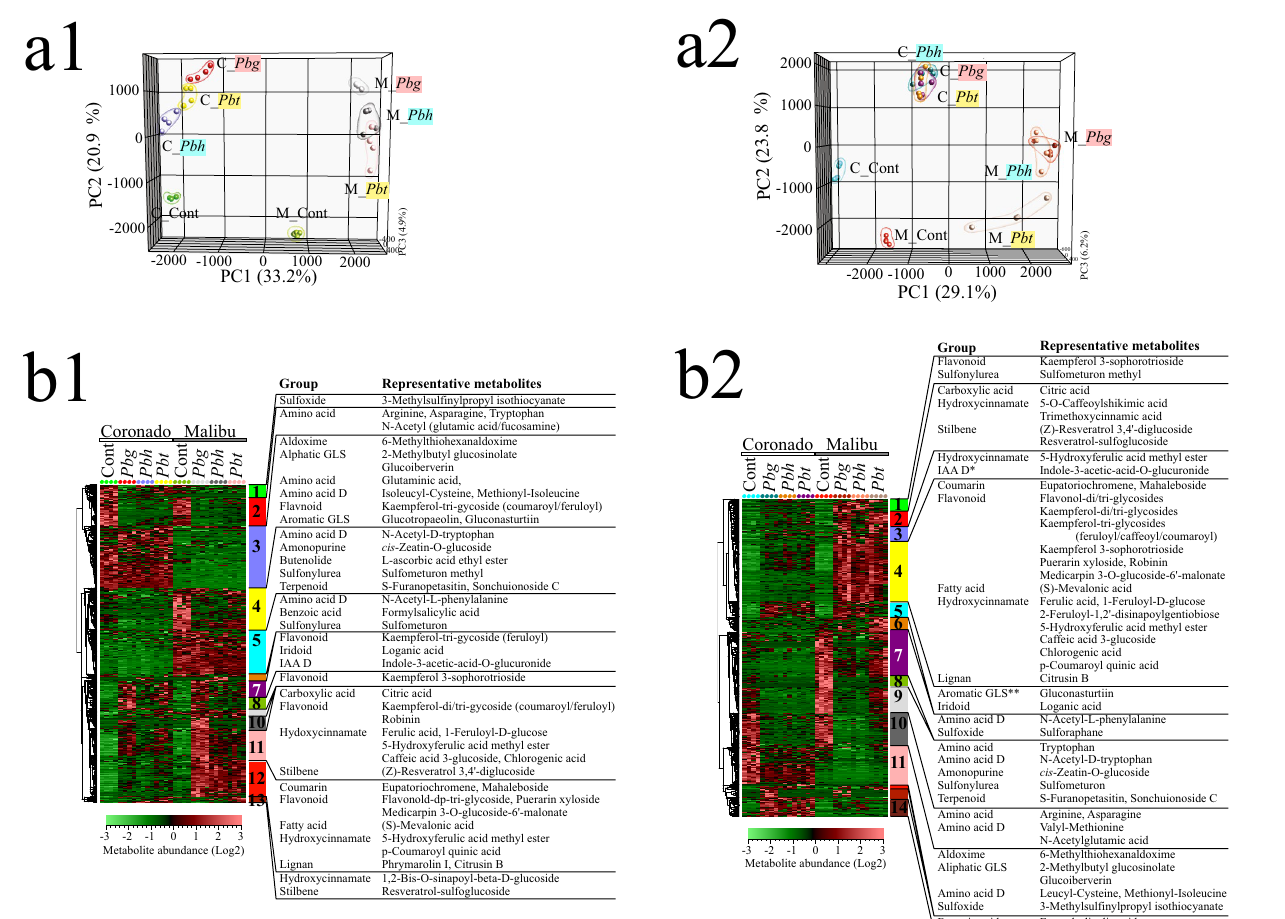
Figure 4. Rhizobacteria-mediated changes in the shoot secondary metabolites in Broccoli cultivars. ( a ) Principal component analysis (PCA) and ( b ) Hierarchical cluster analysis (HCA) based on differentially regulated metabolites of the samples at 6 dpi ( 1 ) and 11 dpi ( 2 ). In the HCA, metabolite clusters are indicated by different colors. Information on the representative metabolites of each clusters is given on the right side, if the metabolites are annotated. Broccoli cultivars (Cor: Coronado, Mal: Malibu), Cont.: non-rhizobacteria treated control, Pbg : Paraburkholderia graminis PHS1, Pbh : P. hospita mHSR1 and Pbt : P. terricola mHS1. *GLS = glucosinolate, **D = derivative. Some primary metabolites were also detected in the semi-polar fraction of the shoot extract, eluting at the early stage of the chromatographic separation and are listed among the secondary metabolites in panels b1 and